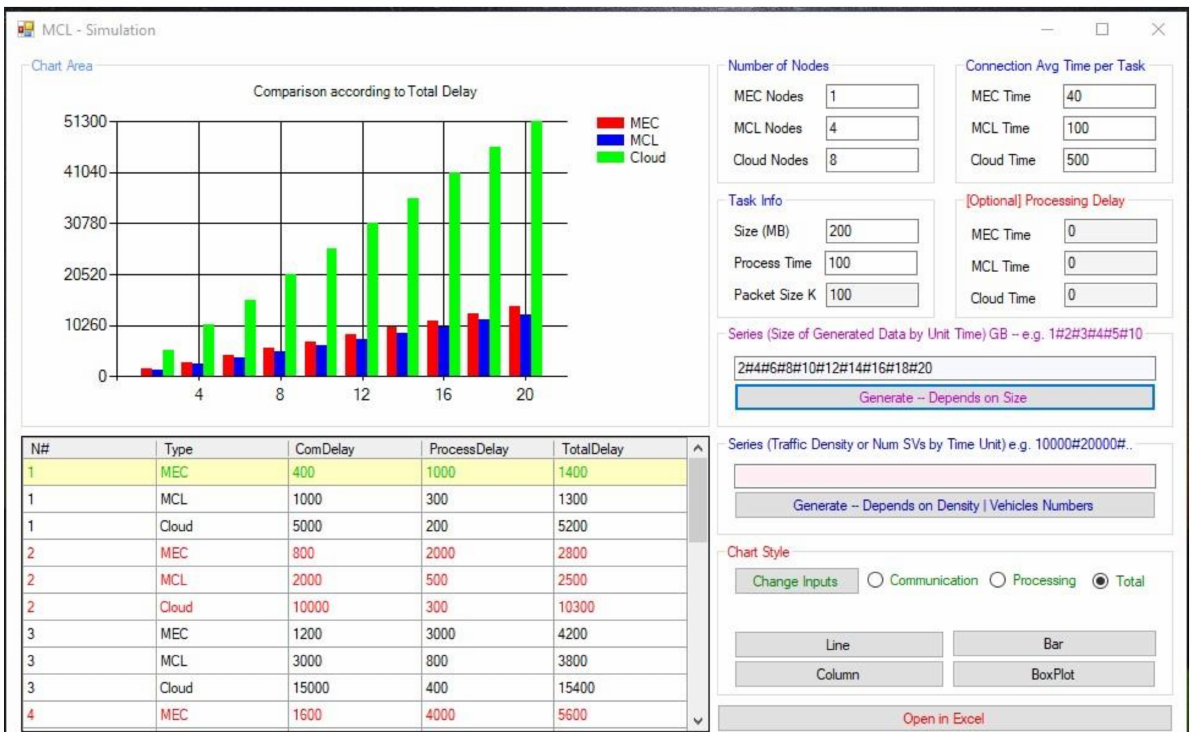
Figure 11. The Computational performance simulation